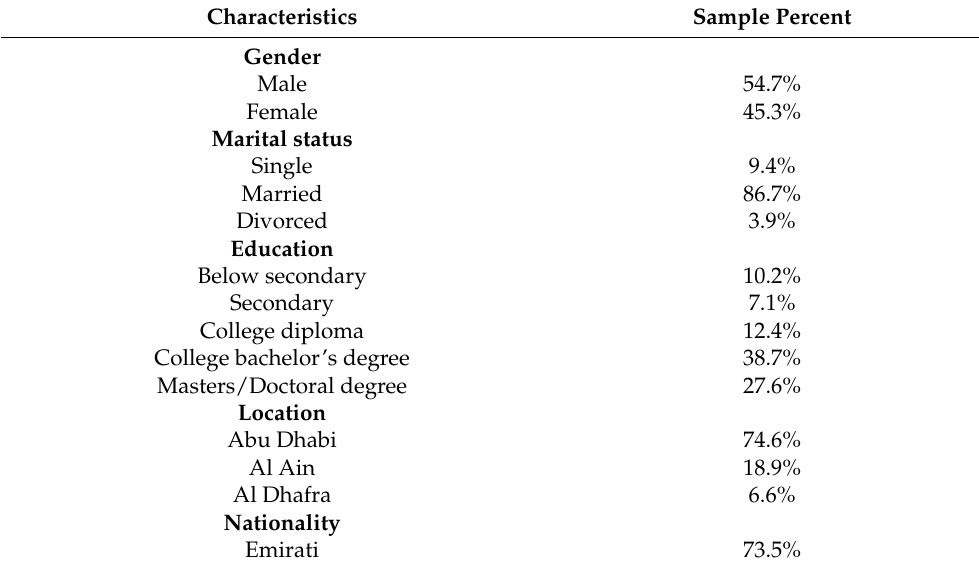
Table 1. Description of sample participants.